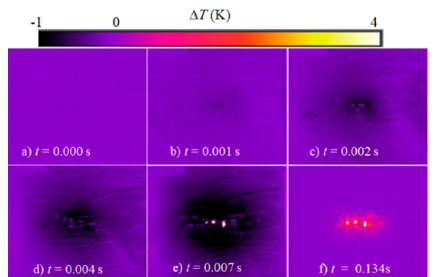
Figure 3. Some Δ T images taken during impact at 11.7